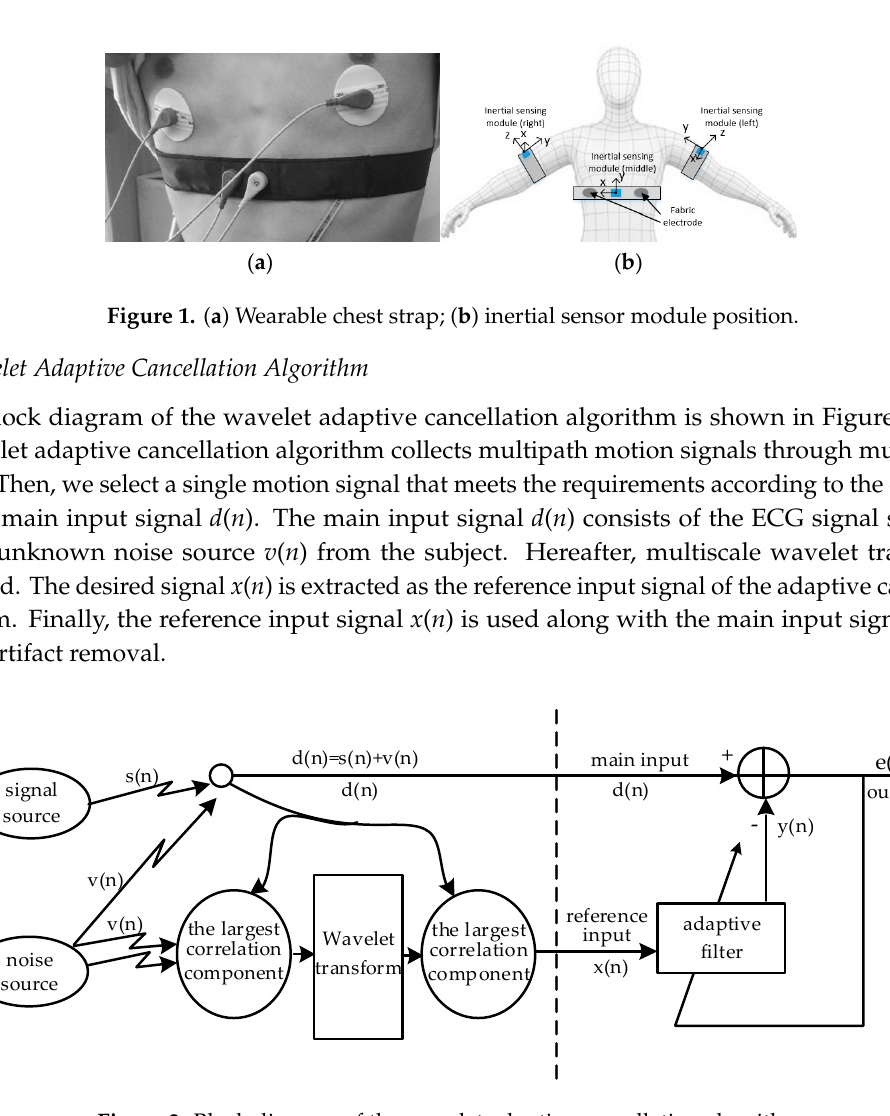
Figure 2. Block diagram of the wavelet adaptive cancellation algorithm.